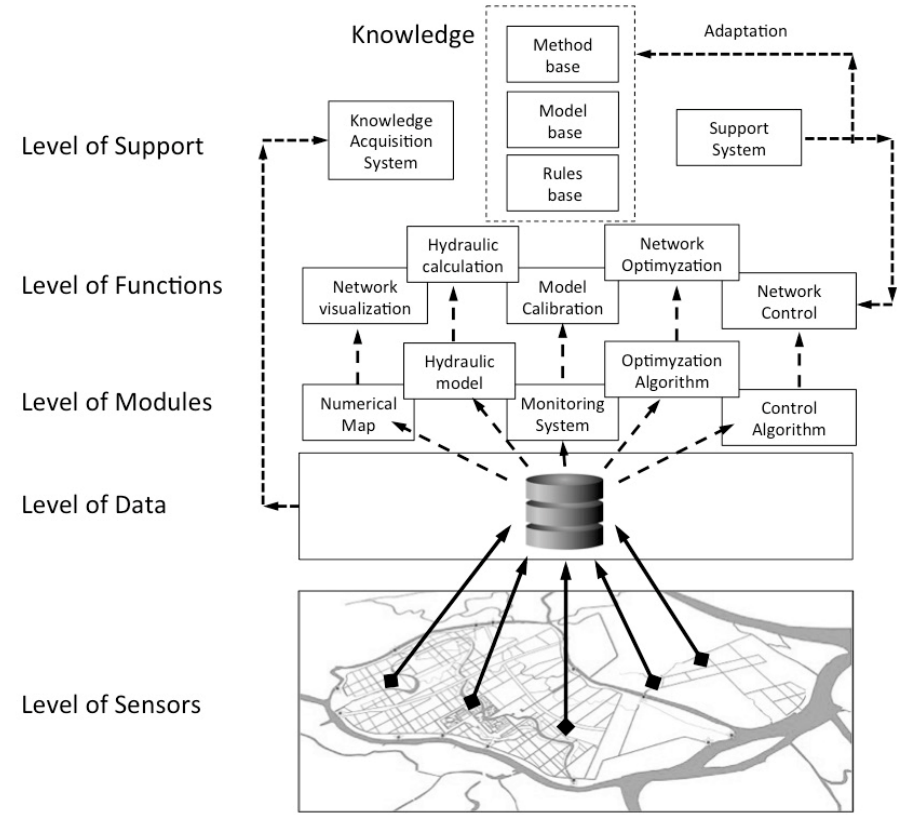
Figure 1. Decision tree of a Water Supply System (WSS).